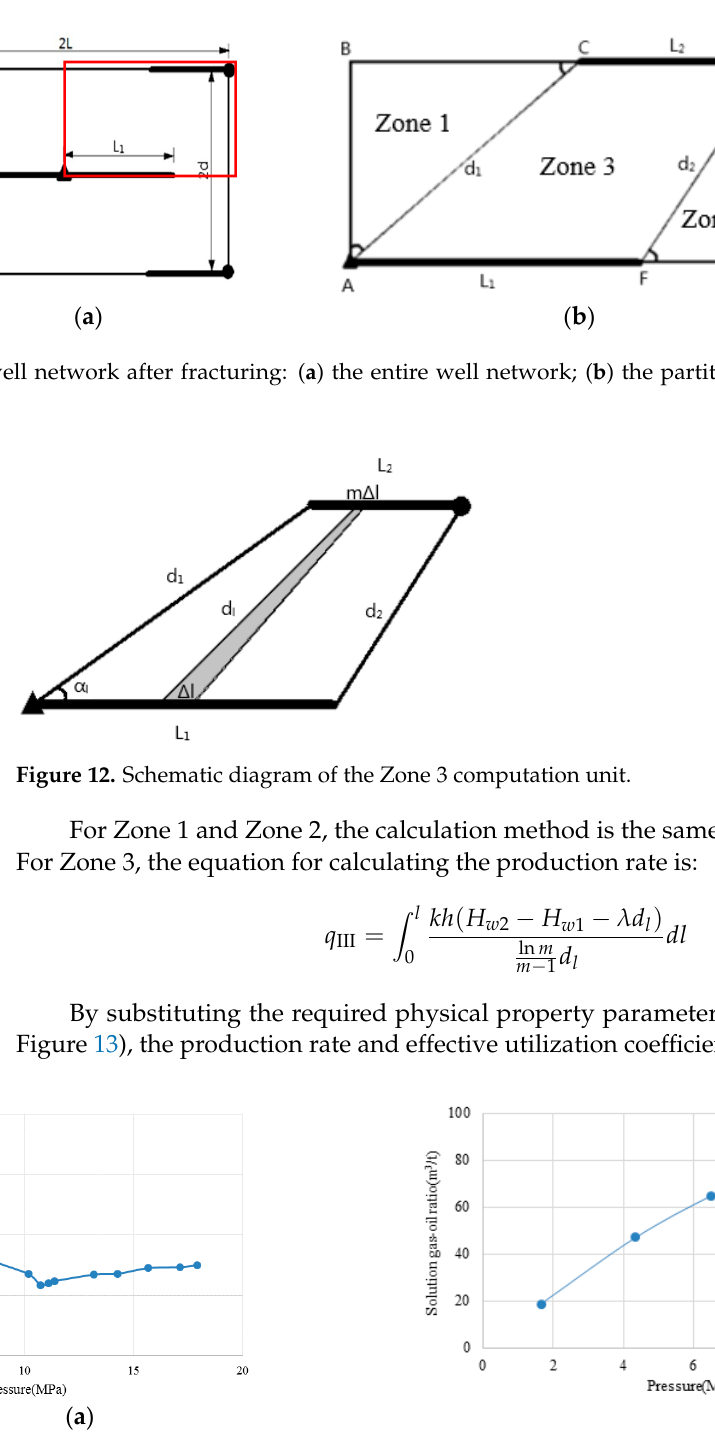
Figure 10. Diagram of the effective utilization factor.